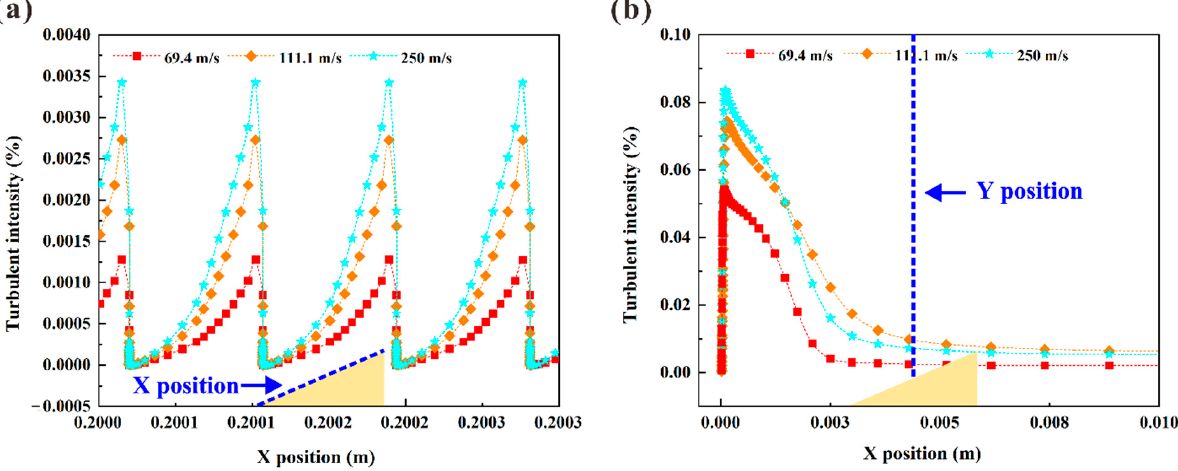
Figure 9. Turbulence intensity of different flow velocities on various directions: ( a ) along the structural surface, ( b ) perpendicular to the structural surface.